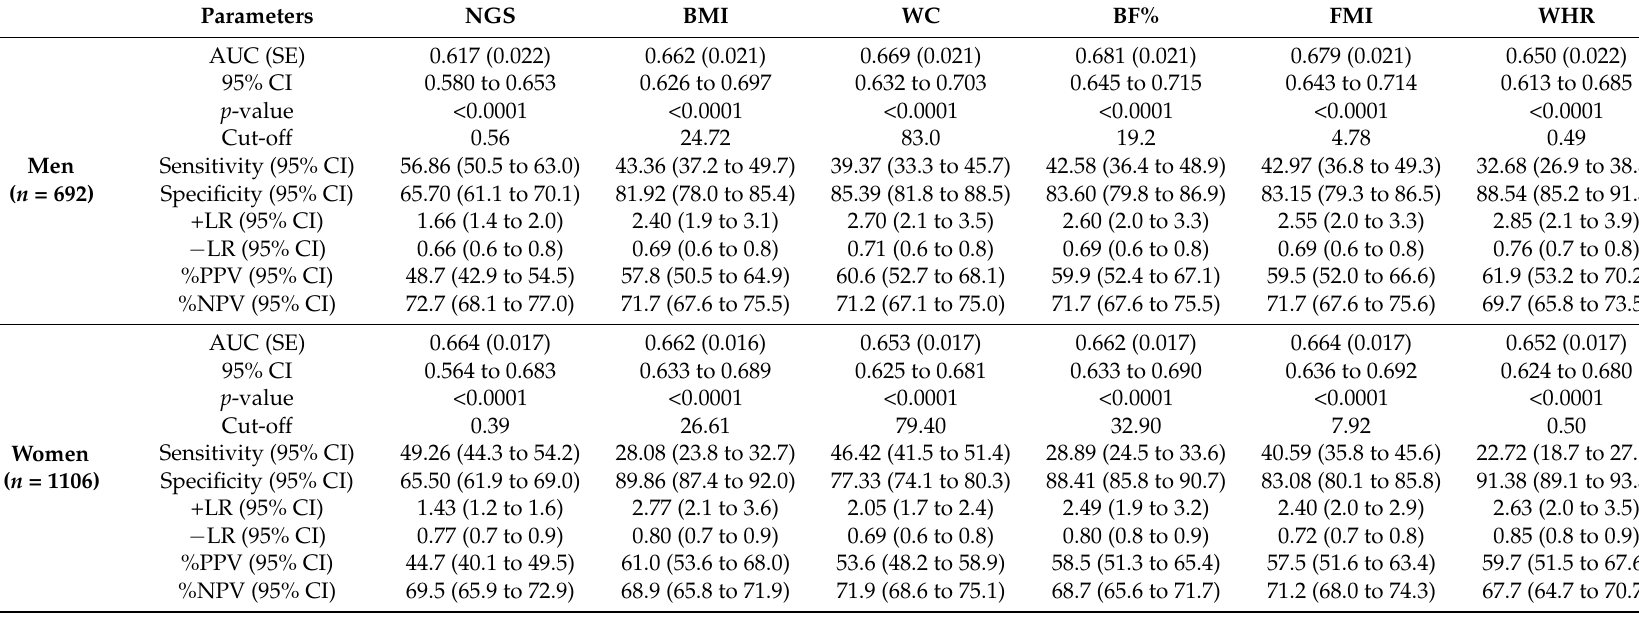
Table 4. Parameters of the ROC curve analysis for the diagnostic performance of fitness and fatness parameters in identifying high cardio-metabolic risk in men and